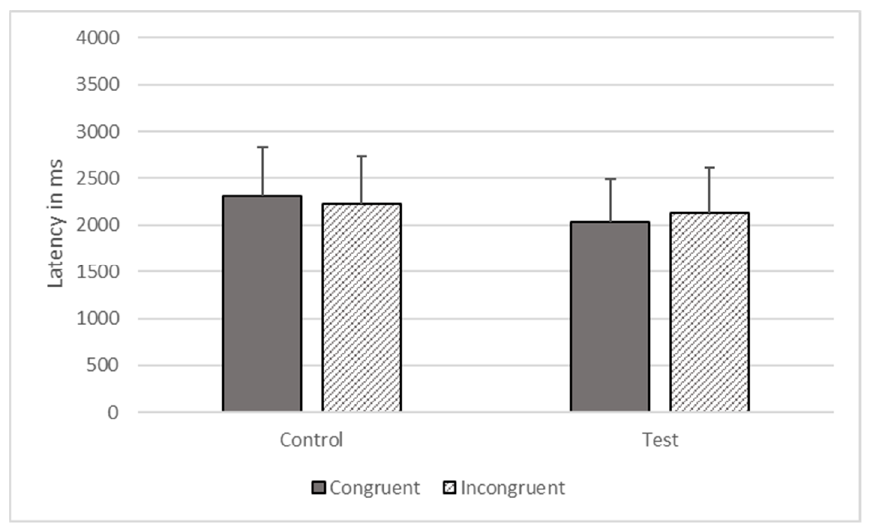
Figure 8. Response latencies as a function of trial types in Phase Six.